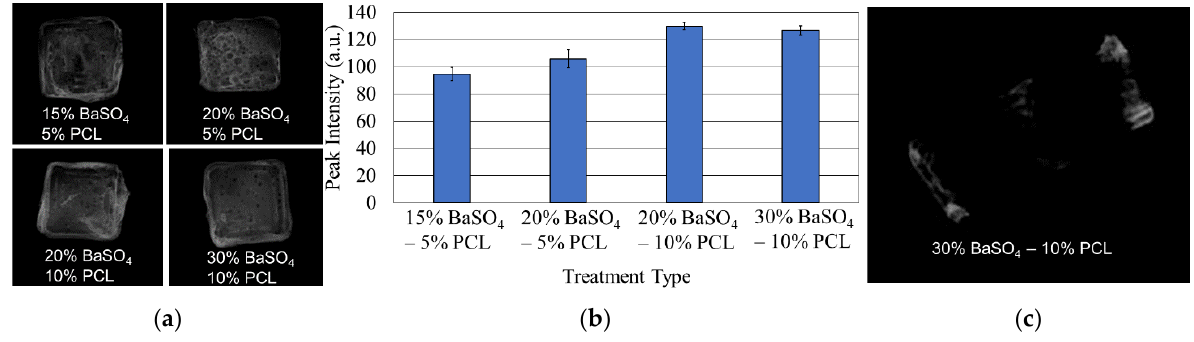
Figure 4. ( a ) X-ray images of flat PCL tiles coated with 15% BaSO 4 and 5% PCL, 20% BaSO 4 and 5% PCL, 20% BaSO 4 and 10% PCL, and 30% BaSO 4 and 10% PCL; ( b ) average peak intensity of coated PCL tiles with ± 1 standard error bars; and ( c ) PCL FDS ends coated with 30% BaSO 4 and 10% PCL.